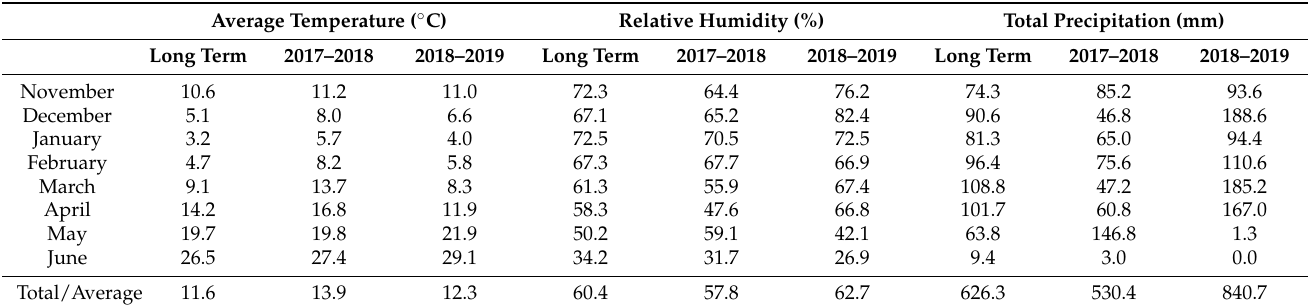
Table 1. Main climate data of the research site for the long term (1981–2019) and for the trial years [32]. Average Temperature ( ◦ C)